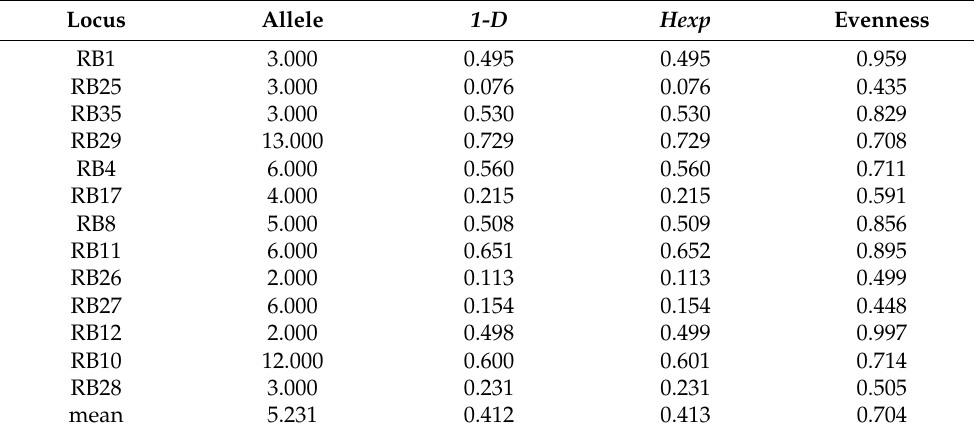
Table 2. Allele, 1-D , Hexp and Evenness of the 13 microsatellite loci isolated from Pt .